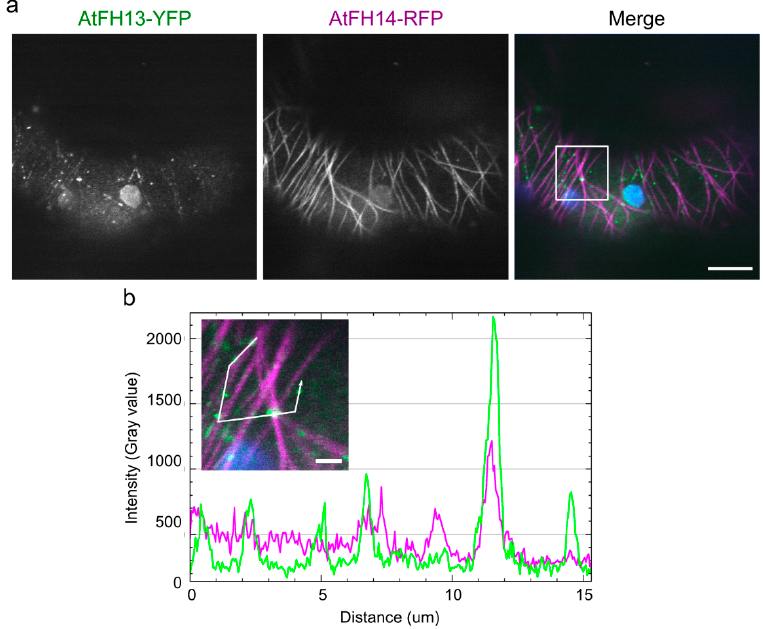
Figure 10. Co-localization of AtFH13 and AtFH14 in transiently transformed tobacco epidermal cells. ( a ) Single optical section of a cell co-expressing AtFH13-YFP and AtFH14-RFP. Images from single channels are shown in grayscale, merged images display an overlay of three channels represented by green (YFP), magenta (RFP), and blue (chloroplast autofluorescence). Note that one of the chloroplasts is probably damaged, exhibiting yellow autofluorescence. Scale bar is 10 µ m. ( b ) Measurement of fluorescence intensity profiles of AtFH13-YFP and AtFH14-RFP along the indicated broken line in arrow direction. Scale bar is 1 µ m. Construct abbreviations are defined in the text and in Figure